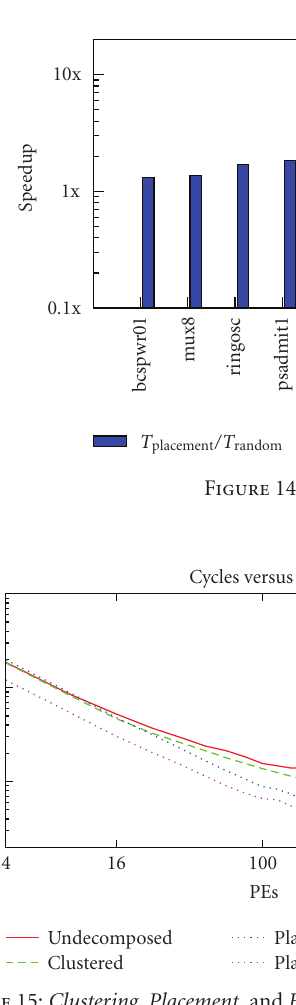
Figure 15: Clustering , Placement, and Fanout-Routing ( ibm01